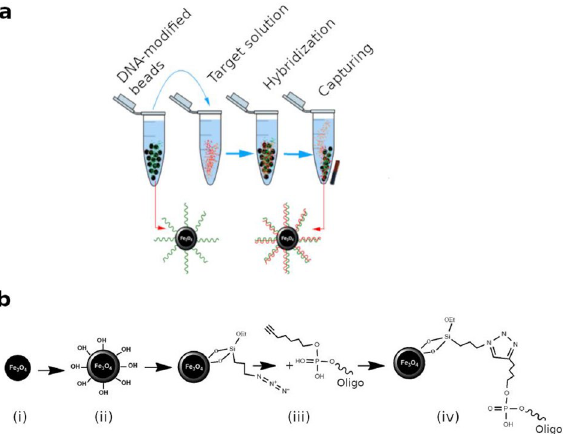
Figure 1. Description of InBeads capture system. ( a ) DNA-conjugated IONPs are incubated with a target solution to promote hybridization. Non-specifically hybridized DNA/RNA are removed by washes. Specifically hybridized DNA/RNA are retained on the magnetically immobilized beads. ( b ) Preparation of InBeads. (i) IONPs synthesis, (ii) silica coating, (iii) azide functionalization, and (iv) conjugation with DNA probes through click